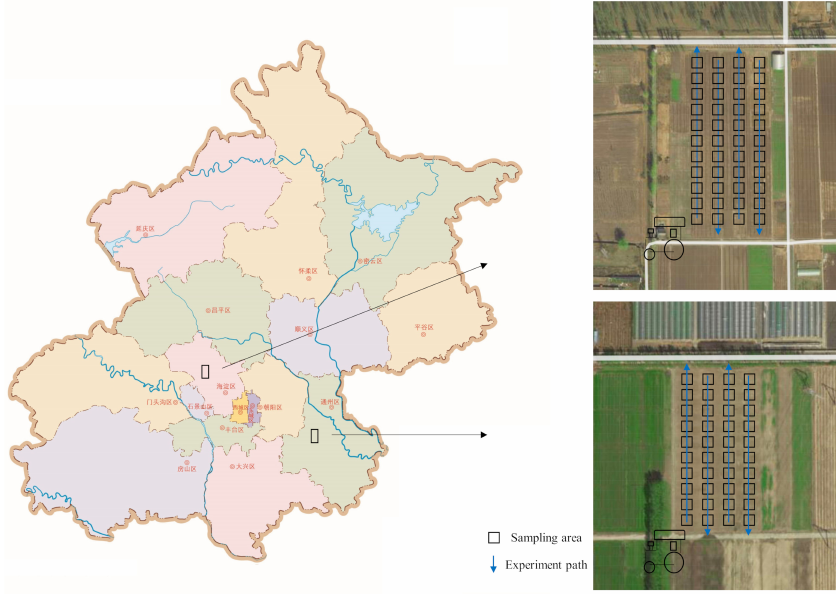
Figure 8. Experimental plots, paths, sampling plots.